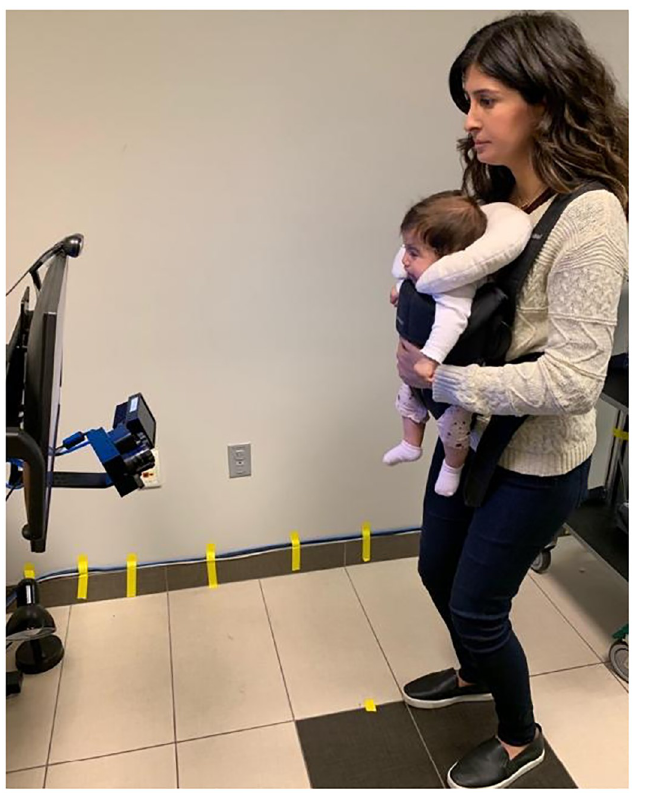
Fig 3. Modifications to standard eye-tracking